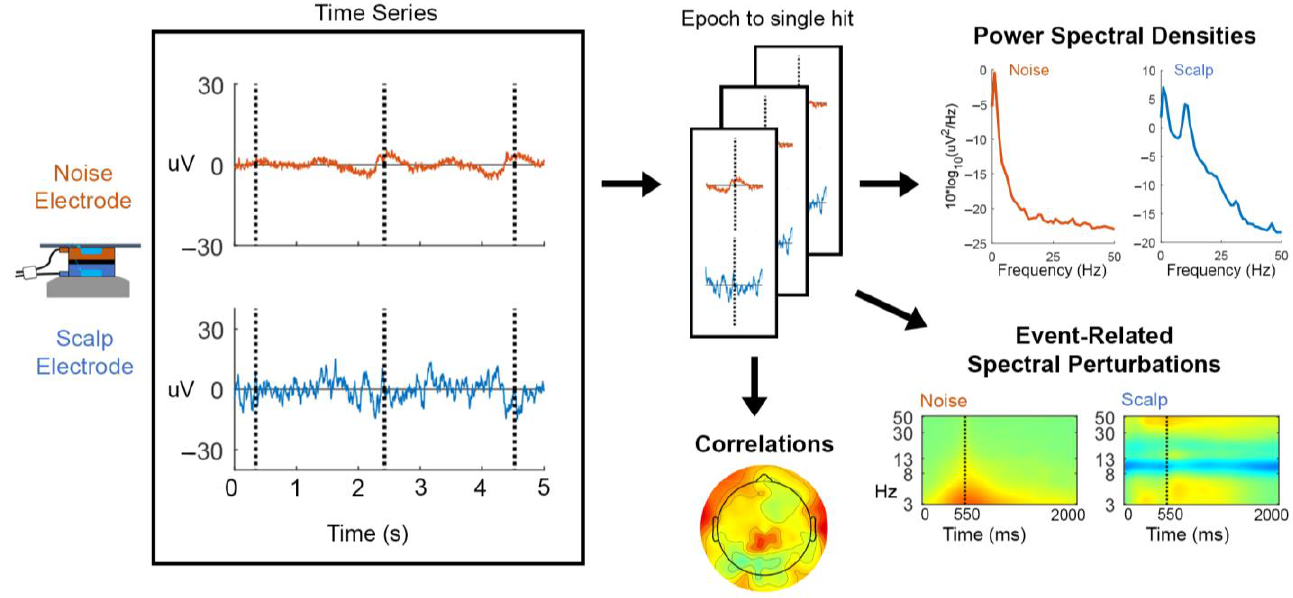
Figure 2. Overview of the artifact characterization process. Time series data of all dual-layer elec- trodes (noise electrode time series in orange and scalp electrode time series in blue) were epoched to single participant hit events. We computed ( 1) power spectral densities of each participant’s sen- sor and for each condition (standing baseline, stationary, moving, cooperative, and competitive), (2) event-related spectral perturbations which were time- warped to an average “swing cycle” whose baseline was the average power from the standing baseline condition, and (3) linear time series cor- relations between all scalp and noise-matched electrodes. This process was repeated for all reference noise sensors, including the bipolar neck EMG, body, and head IMU acceleration data.